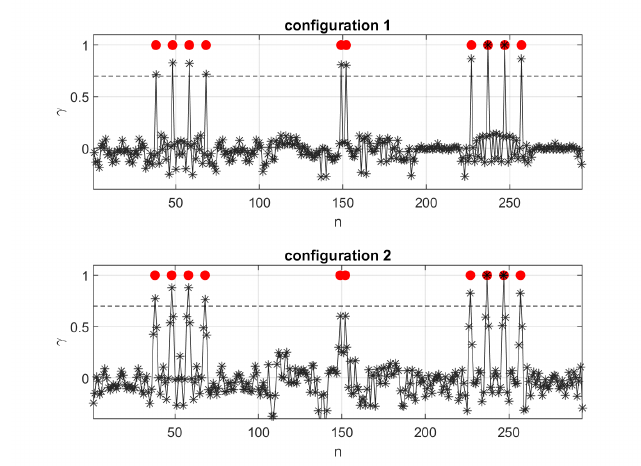
Figure 8. Bars’ detection (configuration 1 and 2 from top ) and reconstructed γ ( n ) ( bottom ). Red circles represent actual bars. Black stars represent detected bars. A threshold of 0.7 has been applied. Note the the two lateral bars are not detected in configuration